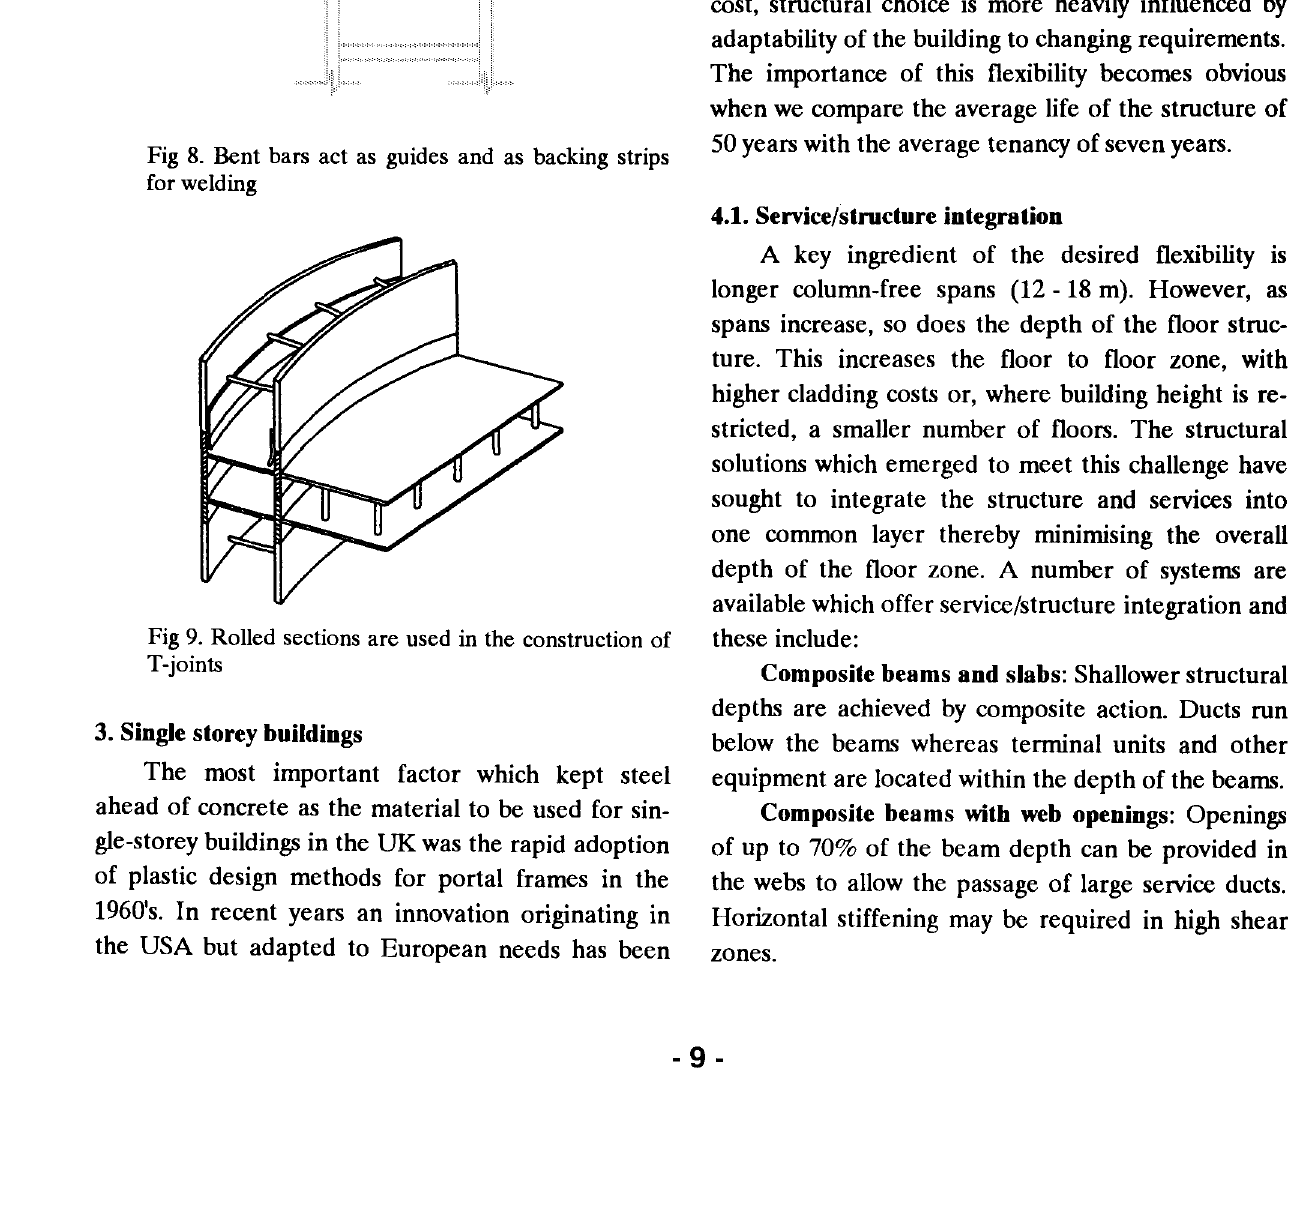
Fig 8. Bent bars act as guides and as backing strips for welding